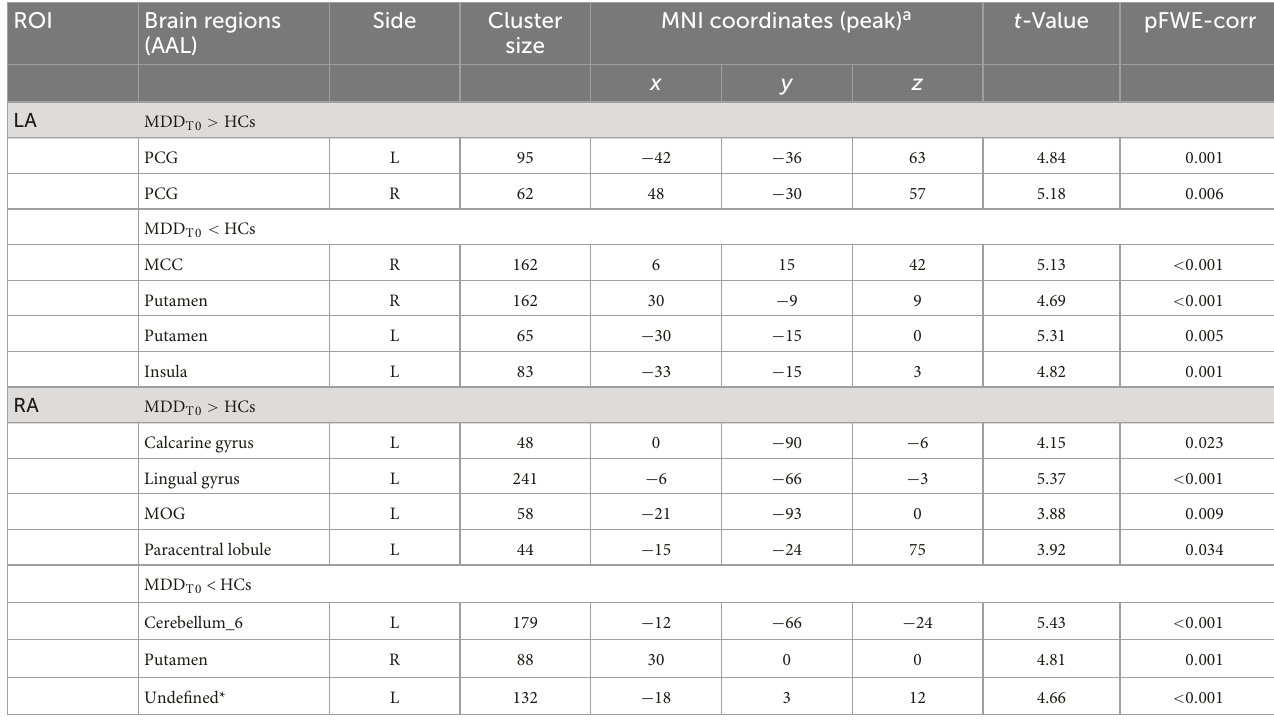
TABLE 2 Abnormal amygdala RSFCs in pre-treatment MDD patients compared to HCs. ROI Brain regions Side Cluster MNI coordinates (peak) a t -Value (AAL) size